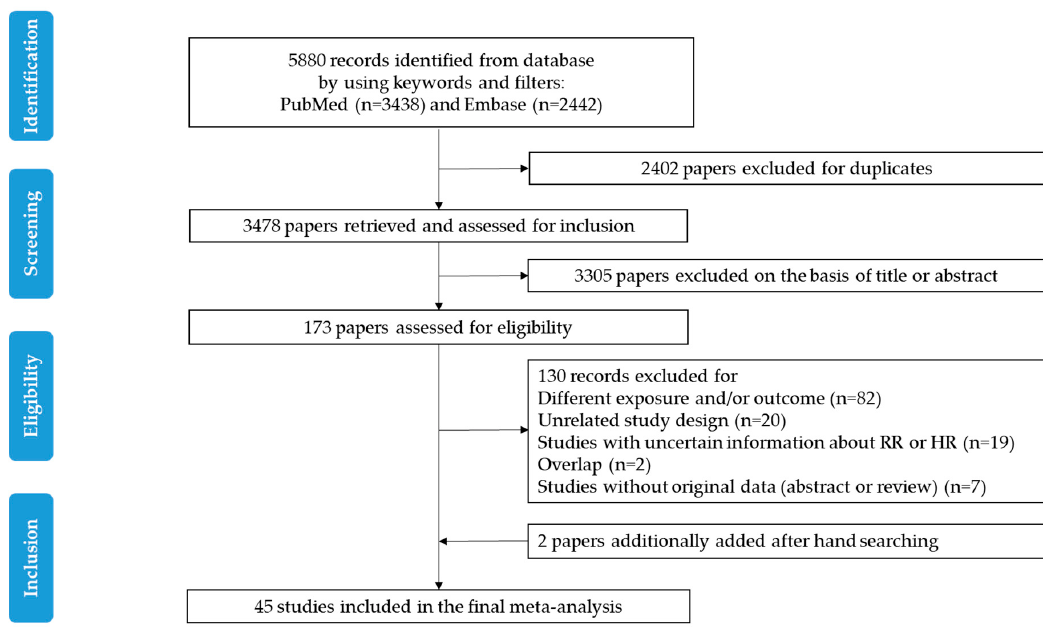
Figure 1. Flow chart of the study selection. The flow chart shows the process used to select prospective studies for the systematic review and meta-analysis of the association between dietary intake and all-cause mortality and colorectal cancer (CRC) mortality among CRC survivors. RR, relative risk; HR, hazard ratio.